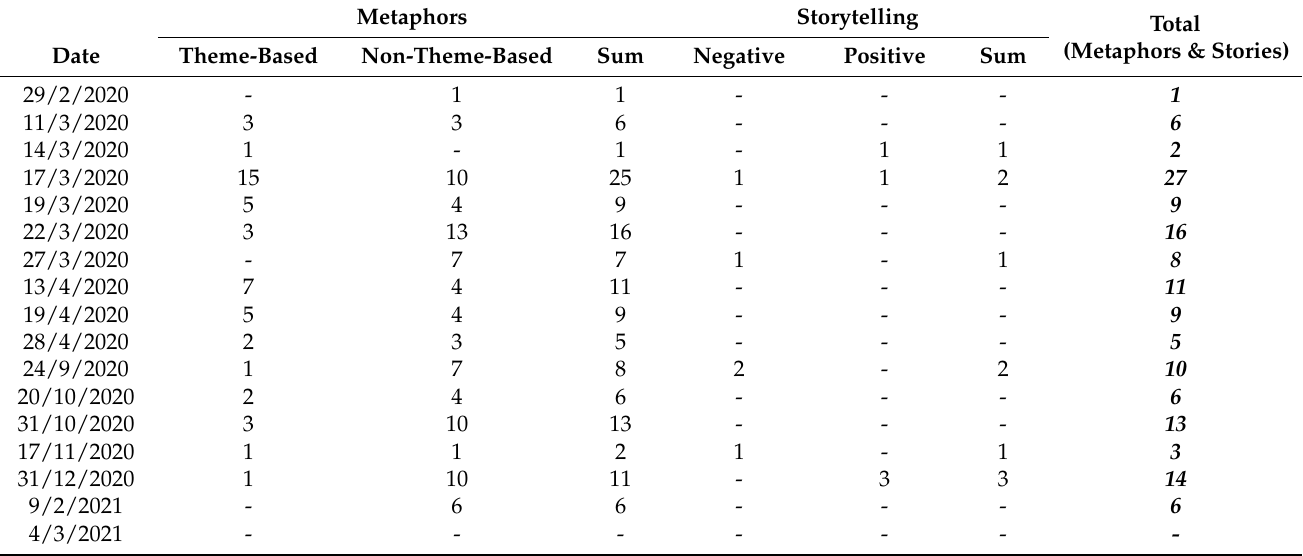
Table 3. Utilization of Different Types of Metaphors and Stories by the Greek PM in Public Addresses during the COVID-19